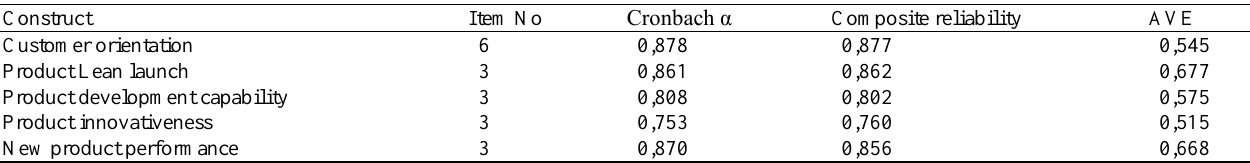
Table 2: Scale reliability and AVE scores